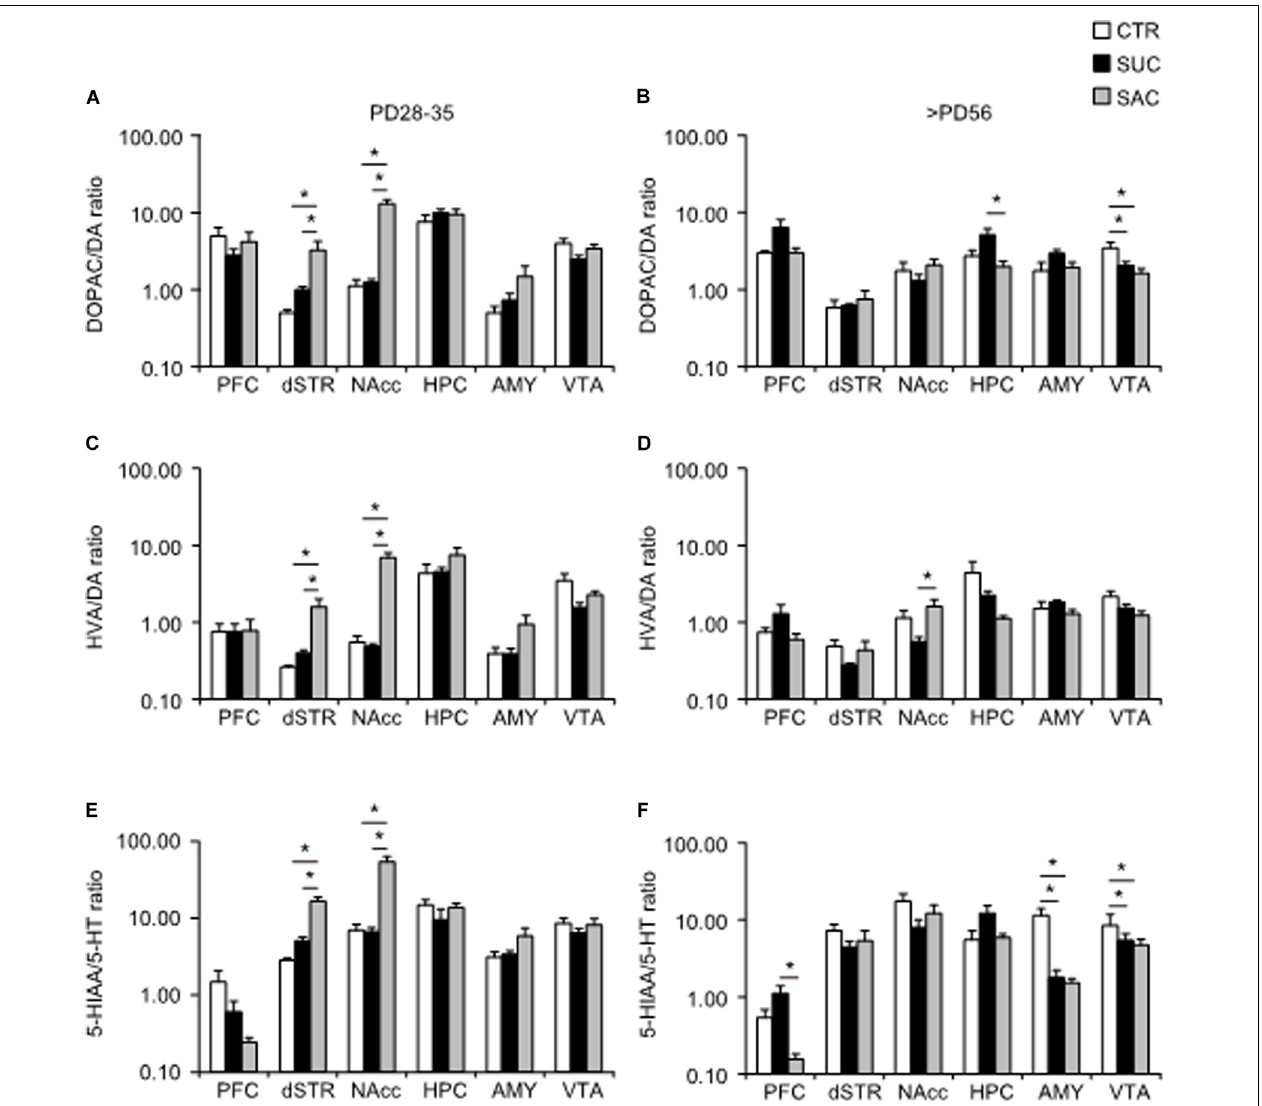
FIGURE 4 | Alterations of ratios between DA/5-HT and their metabolites in mesocorticolimbic regions of animals subjected to sucrose and saccharine treatments. Graphs showing the DOPAC/DA ratio in the PFC, dSTR, vSTR, HPC, AMY, and VTA of juvenile (A) and adult (B) animals. Graphs similar to a and b but showing HVA/DA ratio in juvenile (C) and adult (D) animals. Graphs similar to a and b but showing 5-HIAA/5-HT ratio in juvenile (E) and adult (F) animals. * p < 0.05.